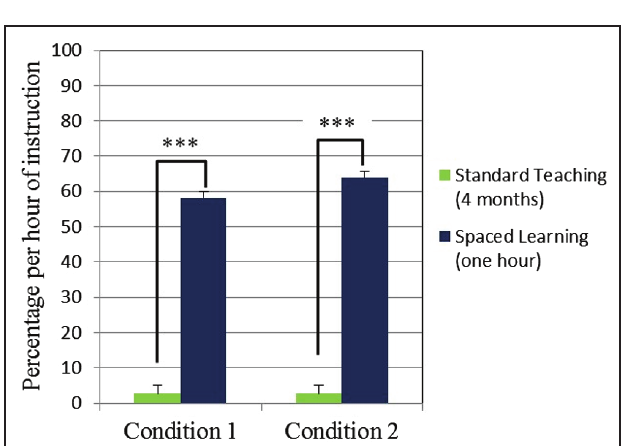
FIGURE 2 | Test score percentage increase per hour of instruction. High-stakes test scores percentage increase per hour of instruction was significantly higher for spaced learning ( N = 46) than for teaching ( N = 127) in Condition 1 *** P < .00001. In Condition 2 the test score increase for spaced learning ( N = 21) was also significantly higher than for teaching ( N = 131) *** P < .00001. All data are means ± SEM.